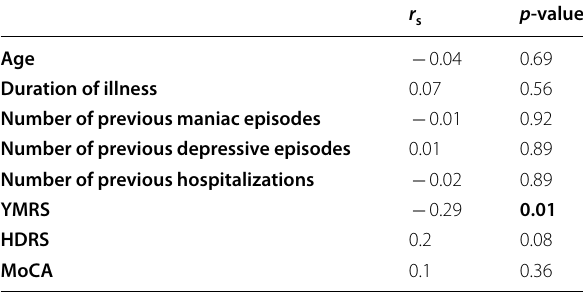
Table 4 Correlation of IL-6 with the clinical characteristics of BP-I patients